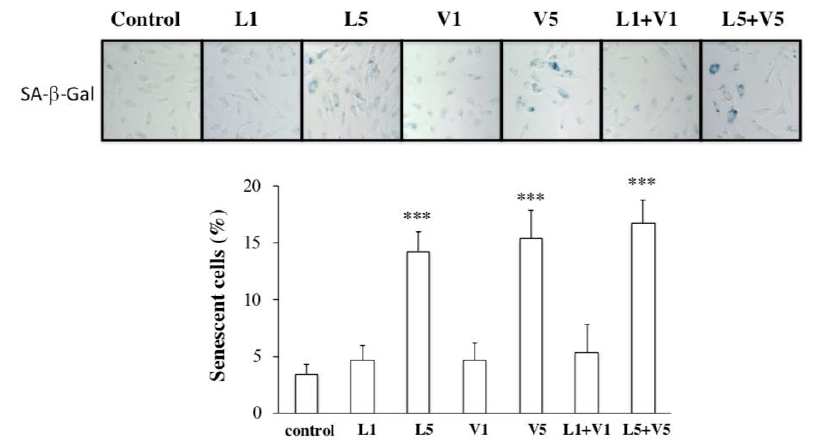
Figure 4. The combined effect of L5 and V5 on cellular senescence in cultured human aortic endothelial cells (HAECs). After treatment with phosphate-buffered saline (PBS; control), L1 (30 µg/mL), L5 (30 µg/mL), V1 (5 µg/mL), V5 (5 µg/mL), or the combination of L1 + V1 or L5 + V5 for 72 h, HAECs were stained with senescence- associated β -galactosidase (SA- β -Gal , blue), and the number of positive-stained cells was quantified. For the quantitative analyses, n = 4 per group. *** p < 0.001 vs. PBS-treated control. 3.4. Endogenous Levels of Electronegative VLDL and LDL Are Increased in the Serum of ApoE − / − Mice